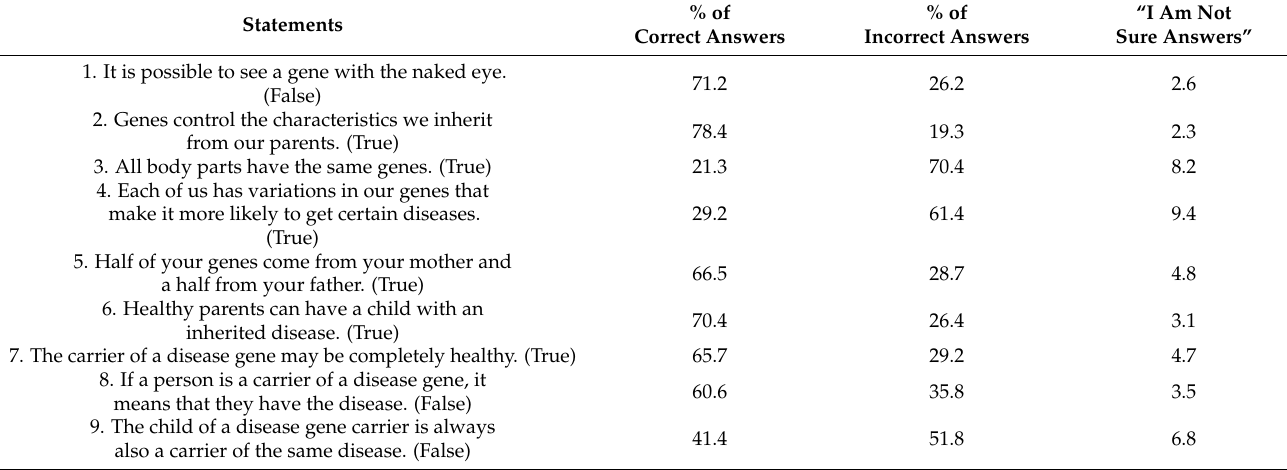
Table 2. People’s General Knowledge of Genetics (N =